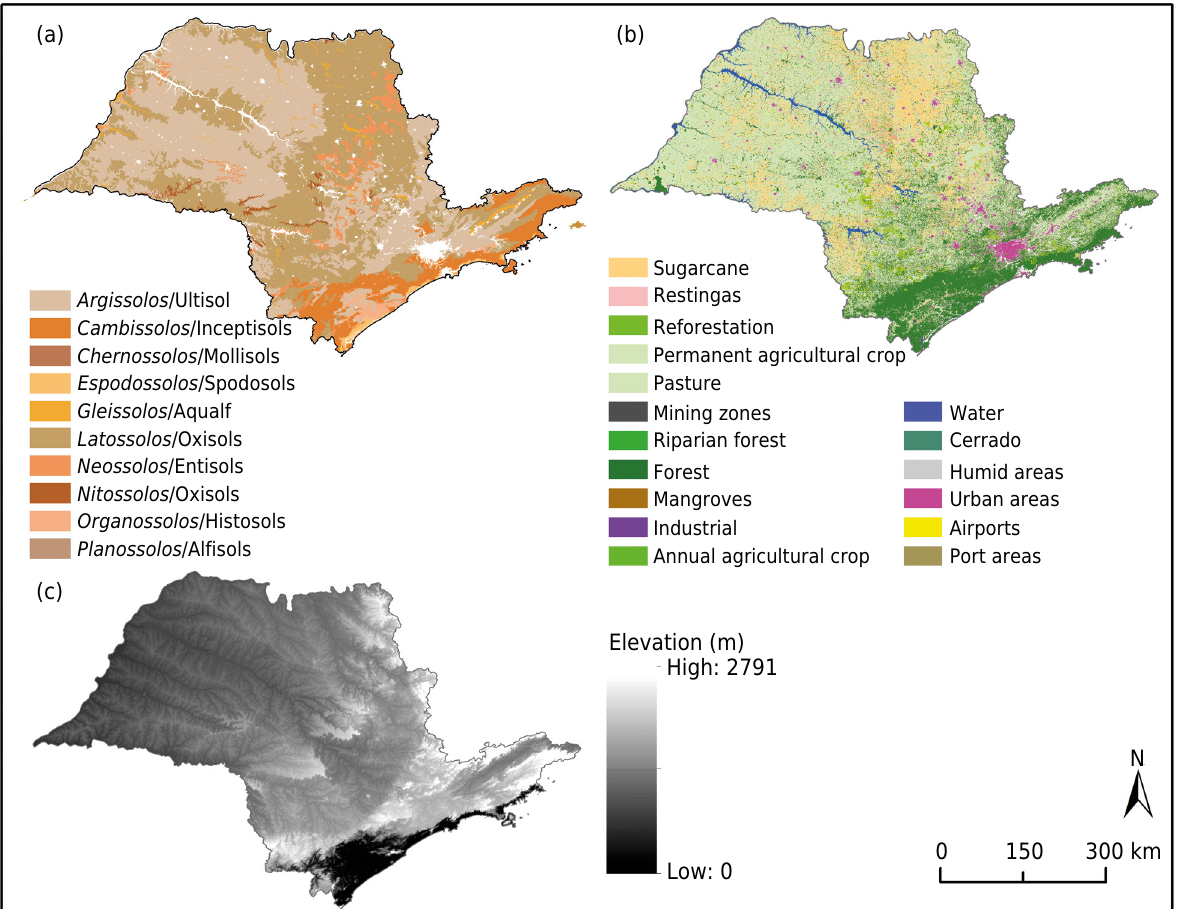
Figure 2. Data used: (a) Pedological map; (b) Land use map of 2005; and (c) Map of Digital Elevation Model (m).